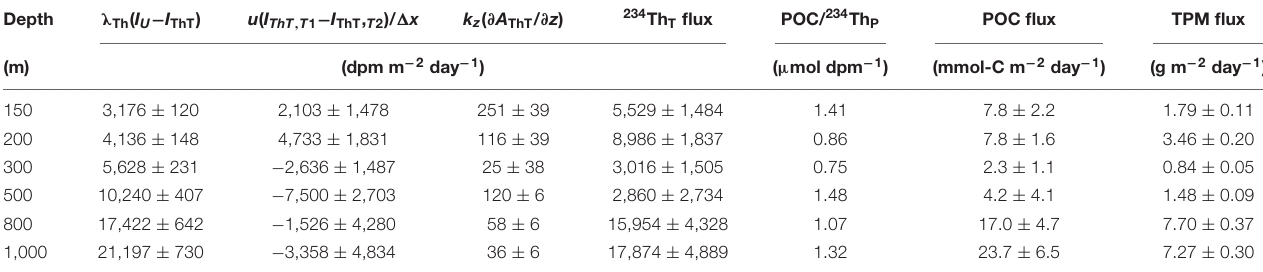
TABLE 2 | Fluxes of 234 Th T and the fluxes of particulate organic carbon (POC) calculated from 234 Th T fluxes below the euphotic zone (150 m). Depth λ Th ( I U − I ThT